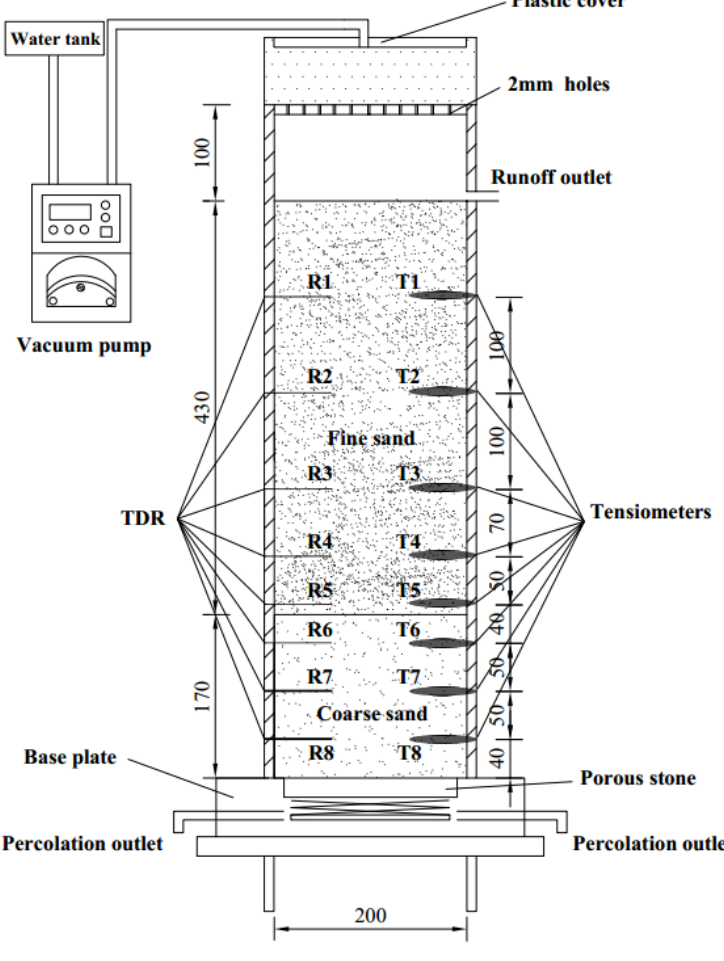
Figure 4. Soil column testing apparatus (mm).